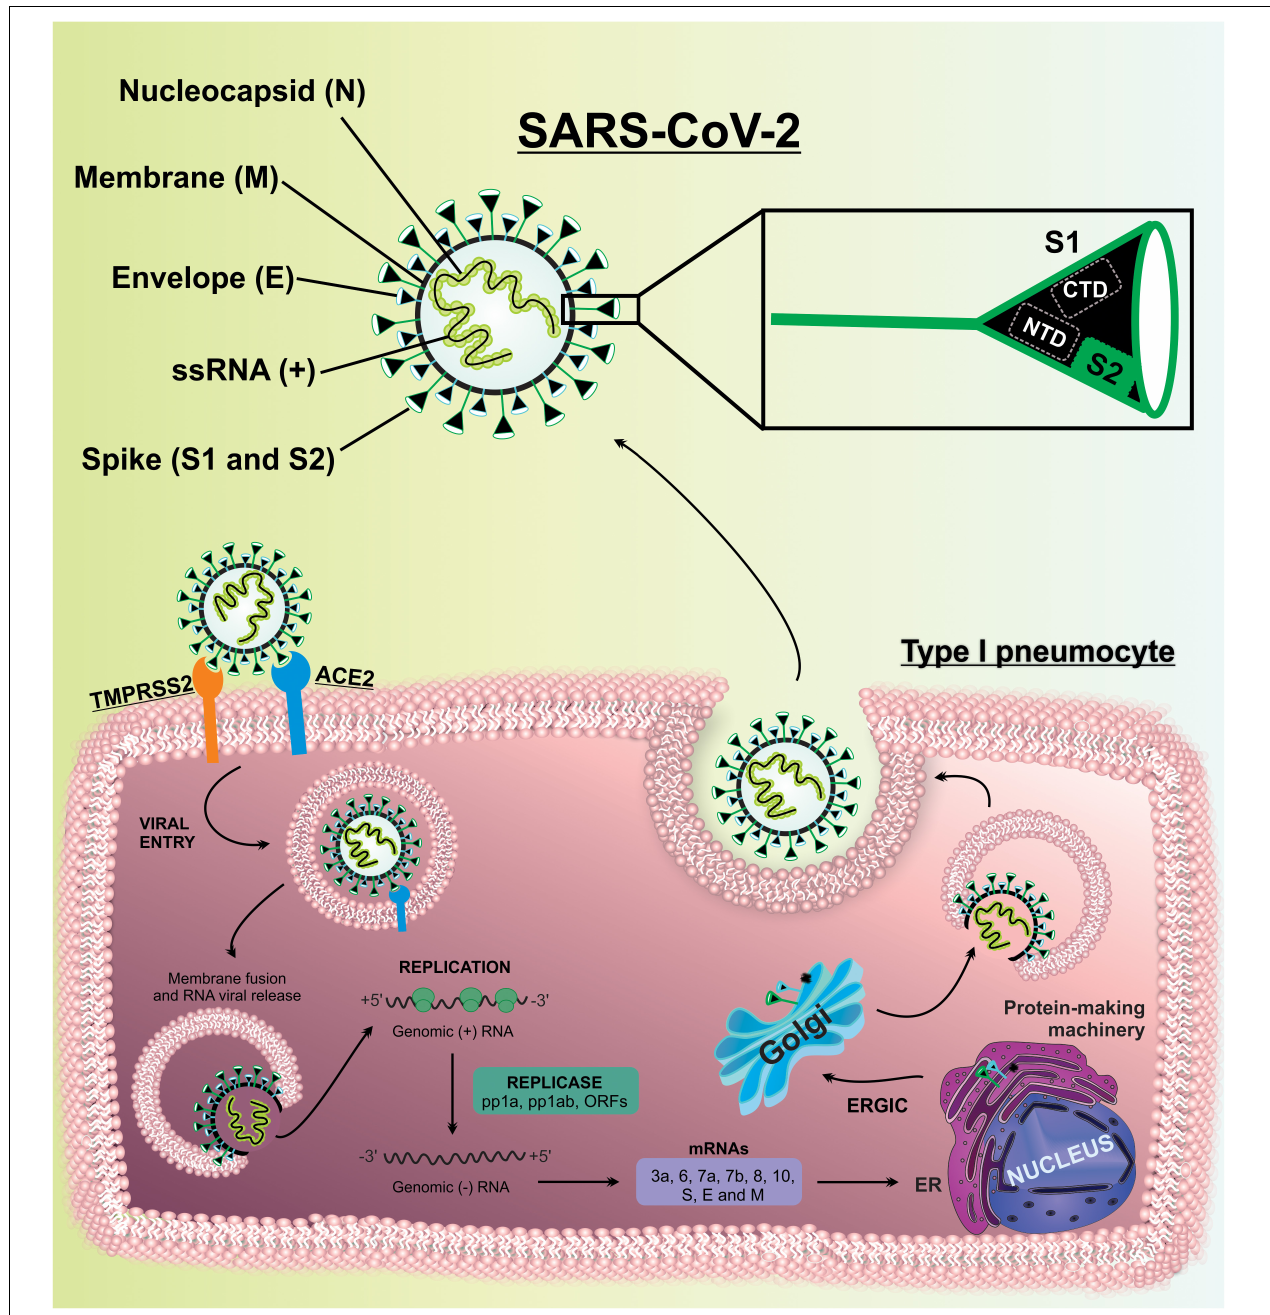
FIGURE 3 | SARS-CoV-2 structure and SARS-CoV-2 replication cycle in lung cells. The main structural proteins of SARS-CoV-2 are spike (S), envelope (E), membrane (M), and nucleocapsid (N) proteins. The S, E, and M proteins are assembled in the viral membrane and the N protein merge in the viral RNA. SARS-CoV-2 interacts with ACE2, and subsequently with TMPRSS2, in lung cells. After SARS-CoV-2 entry occurs the release of viral genome and replication. Structural and non-structural proteins are assembly and packaging to SARS-CoV-2 release by